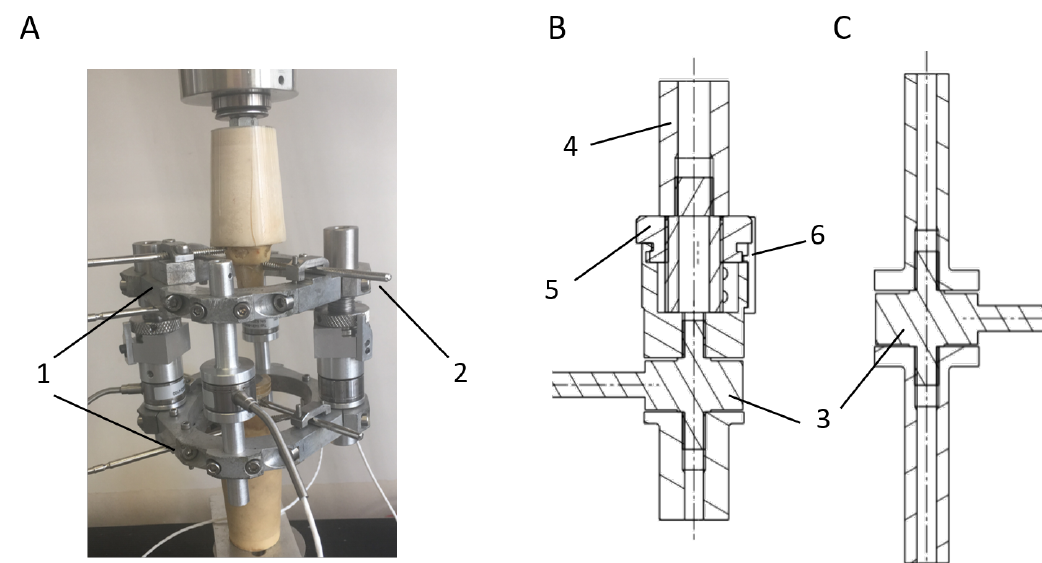
Figure 1. ( A ) Complete external fixator assembled to a sheep metatarsal bone: 1. stainless steel